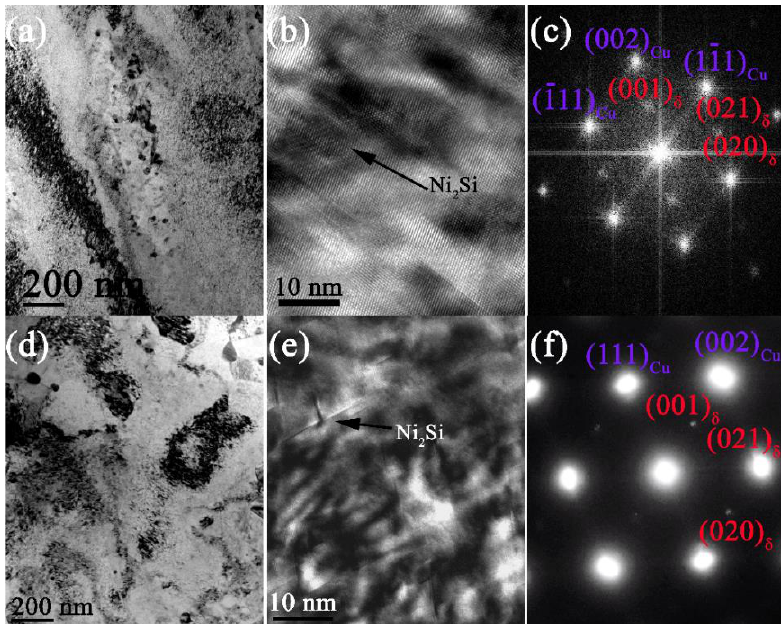
Figure 5. The evolution of precipitation of the Cu-Ni-Si alloy during the two steps of aging treatment containing the first step aging at 500 °C for ( a ) 0.25 h, ( b ) the magnified photograph with ( c )selected areas diffraction patterns (SADP), and ( d ) 0.5 h, ( e ) the magnified photograph with ( f ) SADP.